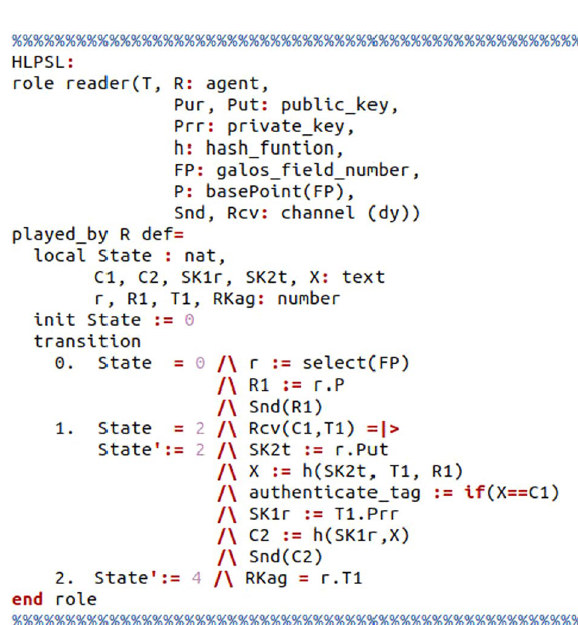
Fig. 5 Authentication steps for the card reader in